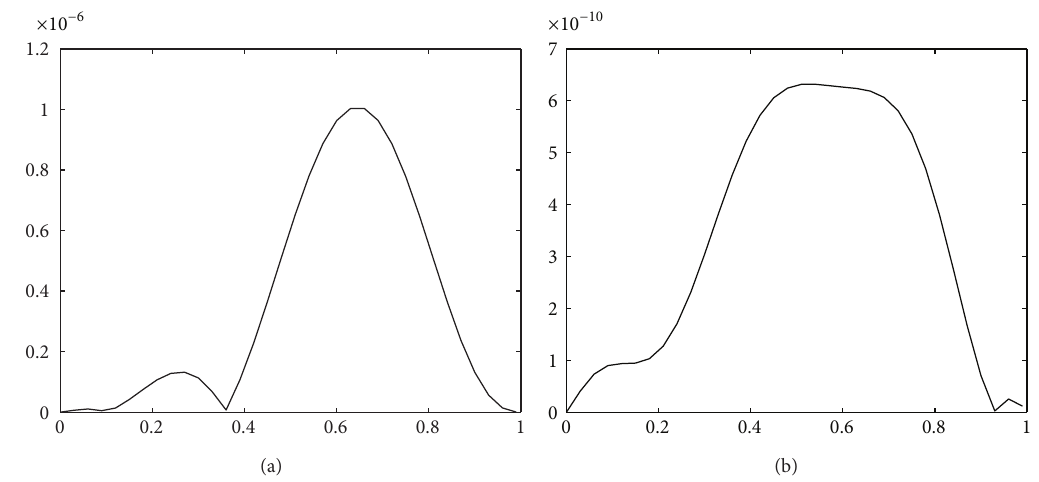
Figure 1: Error function of problem (62) for 𝑚 = 4 (a) and for 𝑚 = 6 (b).